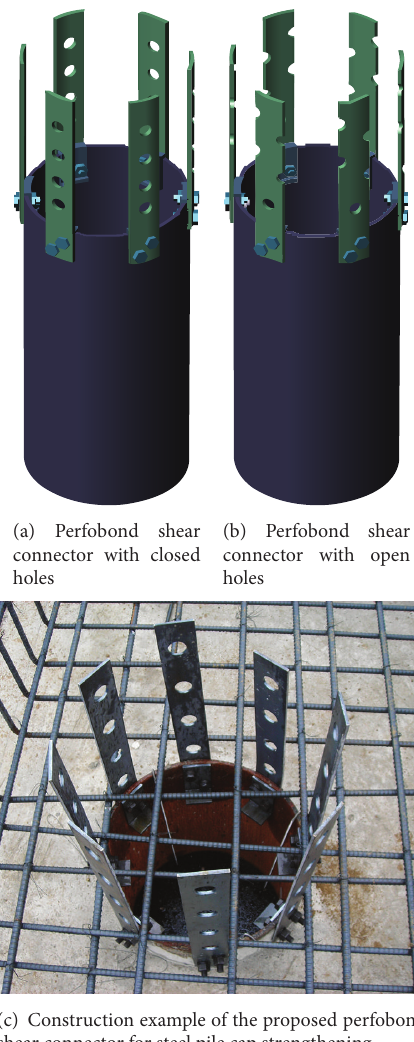
Figure 2: Strengthening of steel pile caps using the perfobond shear